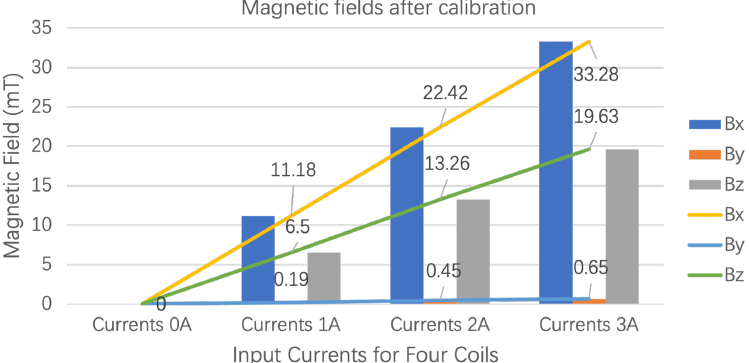
Figure 26. Measured magnetic fields after the calibrations in the workspace